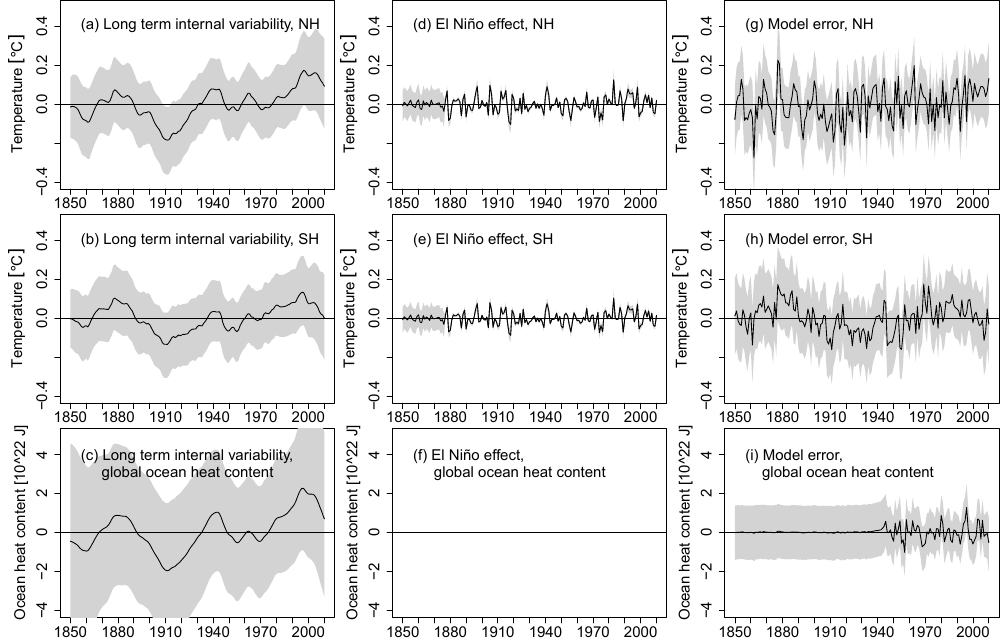
Fig. 4. Posterior estimates of the long-term internal variability term ( n liv t , left column), the ENSO term ( β 1 e t , middle column) and the model errors ( n m t , right column) for the temperature and ocean heat content.